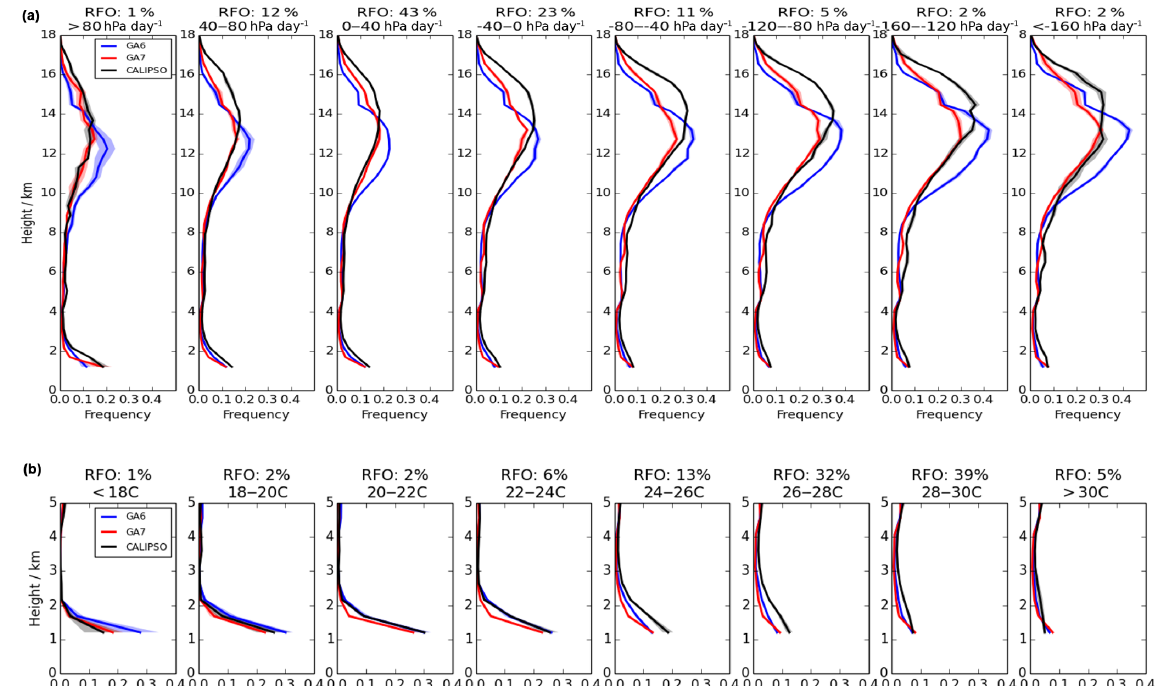
Figure 5. Observed and simulated CALIPSO height–frequency histograms composited by daily ω 500 (a) and SST (b) over the tropics (20 ◦ N–20 ◦ S). Only the region below 5km is shown in the lower plot to focus on low cloud. The range and relative frequency of occurrence (RFO) are shown at the top of each bin. Negative ω 500 indicates ascent. Shading around the line plots has been added to reflect significance bounds; however, this is sometimes less than the thickness of the plotted